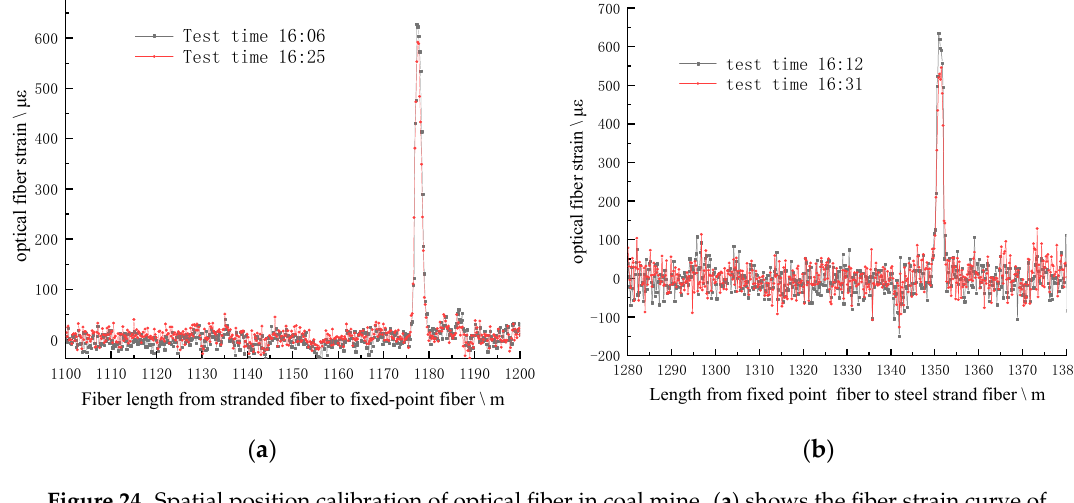
Figure 24. Spatial position calibration of optical fiber in coal mine. ( a ) shows the fiber strain curve of line ① ; ( b ) shows the fiber strain curve of line ②